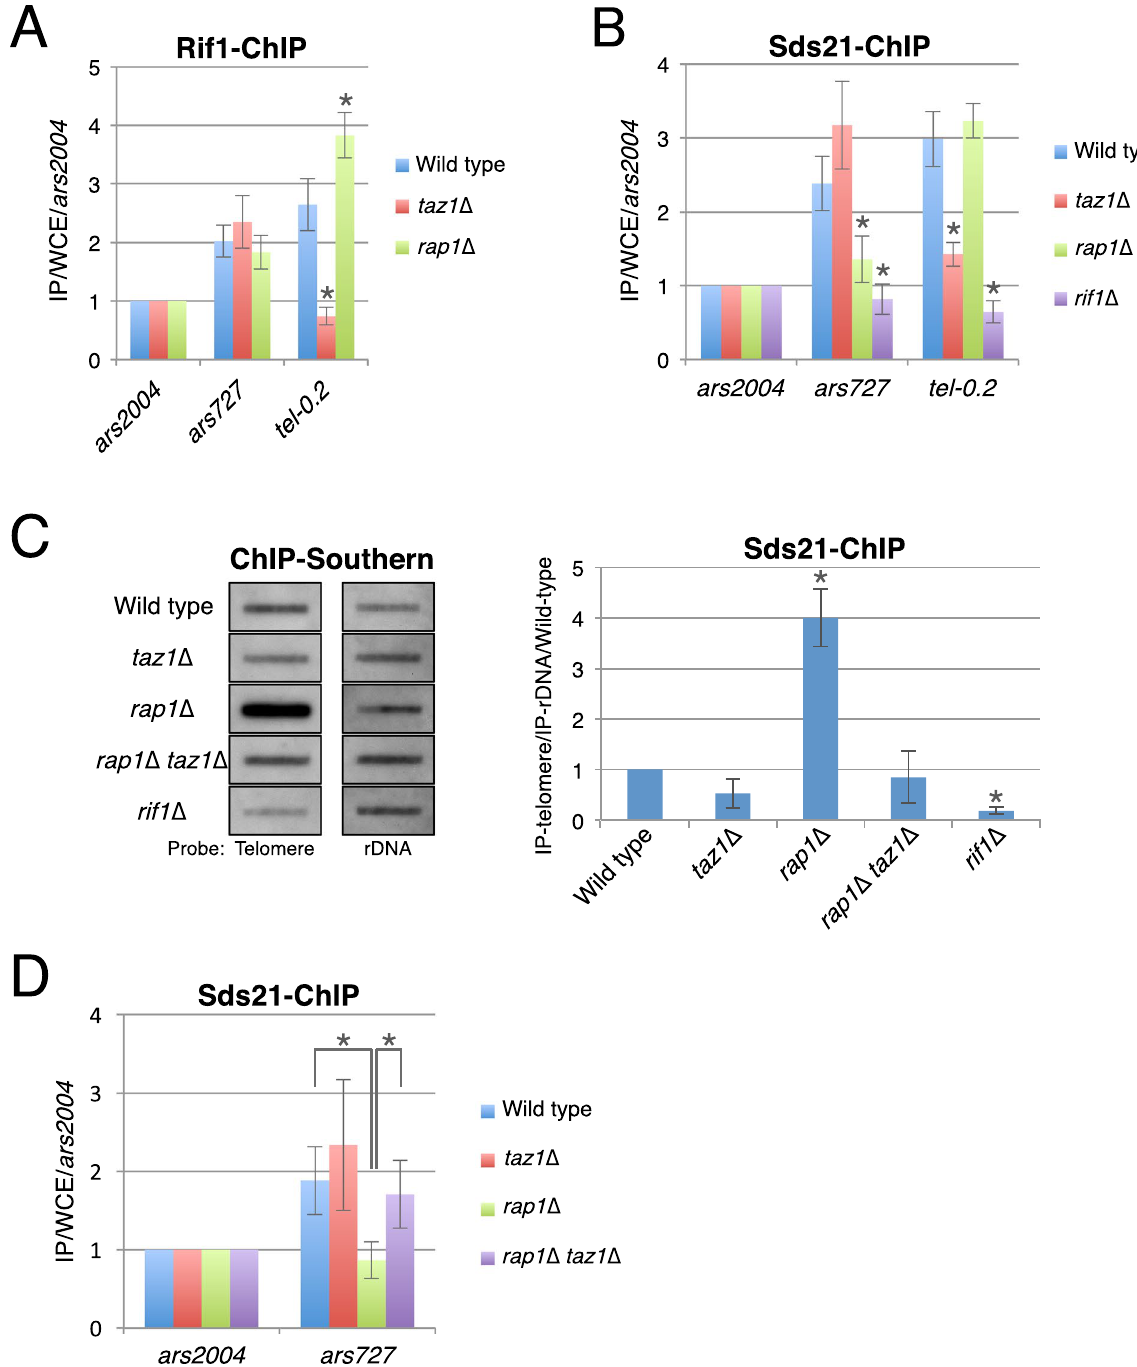
Figure 4. Sds21 is sequestered to excessively elongated telomeres in a Taz1-dependent manner. ( A ) Localization of Rif1 at ars727 was unaffected by Rap1 or Poz1 deletion. ChIP analyses of Rif1-12Myc localization were performed with cells at 60 min after released from G 2 /M arrest. Co-purified genomic DNA was analyzed by qPCR. Each value was normalized to that of ars2004 . Error bars indicate the s.d. ( n = 3). Asterisks indicate a significant change as compared with the wild-type strain ( p < 0.05, Student’s t-test). ( B ) Sds21 localization at ars727 was decreased by Rap1 deletion. ChIP analyses of Sds21-3Flag were performed with cells at 60 min after released from G 2 /M arrest. Each value was normalized to that of ars2004 . Error bars indicate the s.d. ( n = 3). Asterisks indicate a significant change as compared with the wild-type strain ( p < 0.05, Student’s t-test). ( C ) Sds21 accumulates at telomeres in rap1 ∆ cells. DNA co-precipitated with Sds21-3Flag was analyzed by Southern blotting using telomere and rDNA (control) probes. Left panel, representative images cropped from the same Southern blots (the original blots are displayed in Supplemental Fig. S3). Each signal compared with its background was analyzed by ImageJ software (NIH, Bethesda, MD, USA) and